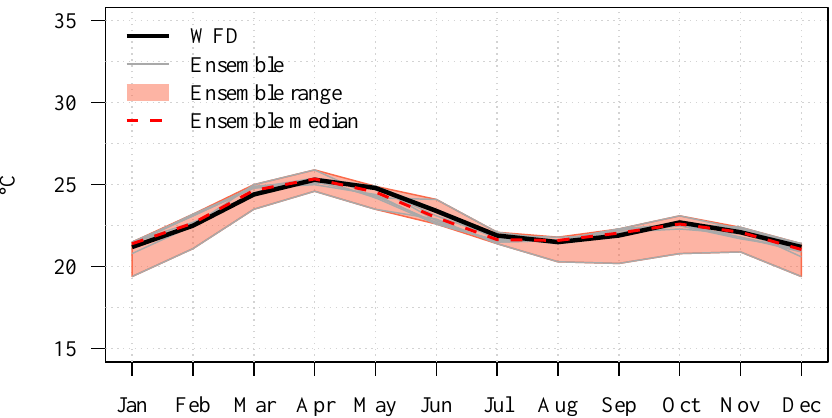
Figure 3. Average monthly mean air temperature in the historical period (1970–1999) of Watch Forcing Data (WFD) and the 10 climate models (ensemble) used in this